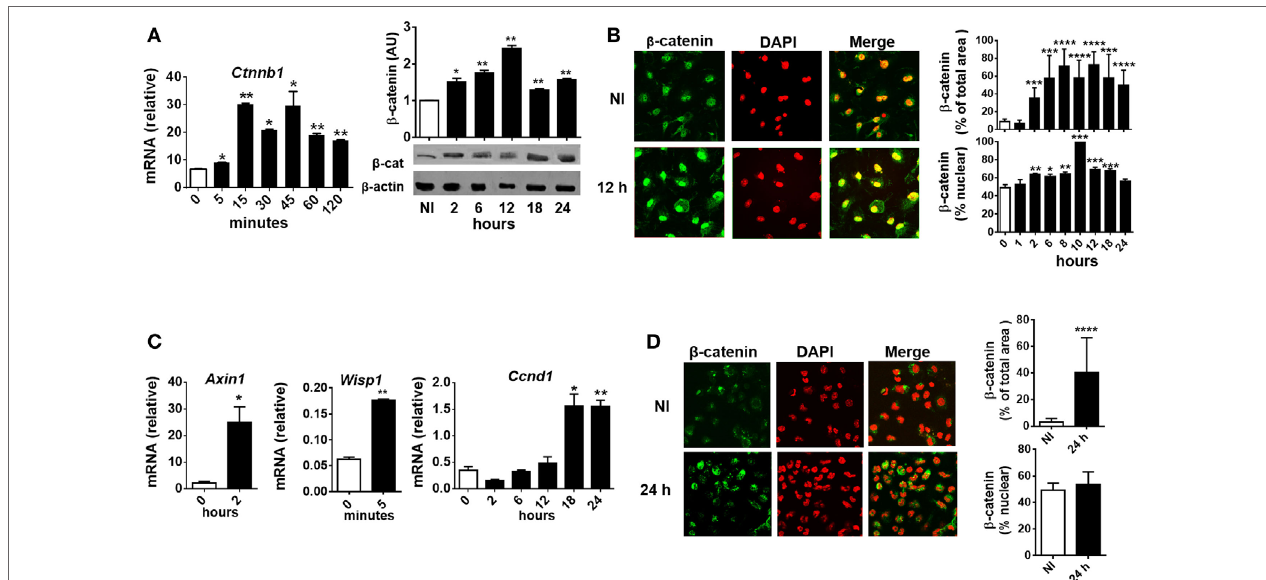
FigUre 3 | Trypanosoma cruzi infection induces early β -catenin activation in macrophages . Bone marrow-derived macrophages were in vitro infected with trypomastigotes of T. cruzi or left uninfected (NI) and then evaluated for β -catenin activation. (a) mRNA and protein expression levels of β -catenin by q-PCR and Western blot at different times post-infection (pi). β -Catenin mRNA relative to β -actin is shown. A representative Western blot and the ratio of β -catenin to β -actin are shown. The results are expressed as the average of three independent experiments ± SEM. Abbreviation: AU, arbitrary units. (B) Expression and localization of β -catenin by immunofluorescence and confocal microscopy. (c) mRNA relative expression of β -catenin target genes Axin1, Wisp1, and Ccnd1 by q-PCR. mRNA expression levels normalized over the expression of β -actin are expressed as the average of three independent experiments ± SEM. (D) Peritoneal macrophages were obtained from uninfected or infected mice at 24 h pi, and the levels of expression and localization of β -catenin were evaluated by immunofluorescence and confocal microscopy. In panels (B,D) , a representative field for each group is shown [ (B,D) , 1,200 × ]. Nuclear staining was detected with 4 ′ ,6-diamidino-2- phenylindone (DAPI), and the levels of expression of β -catenin (% of total area) and the threshold Mander’s colocalization (% nuclear) coefficients calculated using FIJI/ImageJ program as described in Section “Materials and Methods.” Green, β -catenin; red, DAPI (* P < 0.05; ** P < 0.01; *** P < 0.001; and **** P <